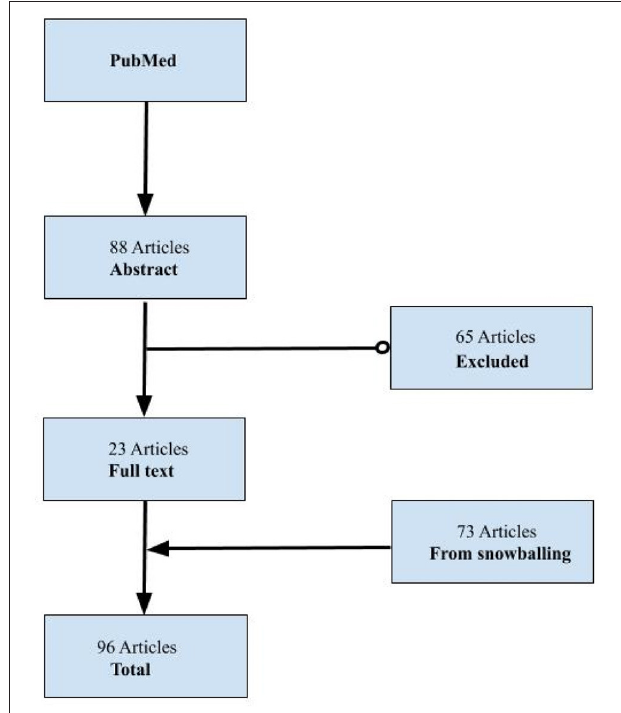
FIGURE 1 | Scoping literature search results and snowball